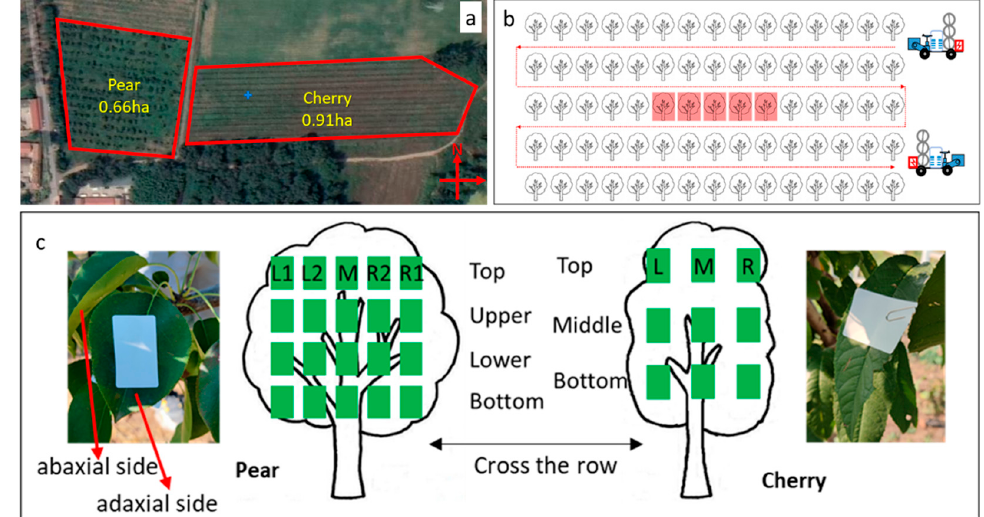
Figure 2. ( a ) Test fields for spray test ( b ) Layout of spray test: the red line showed the application route, trees with red background were sampled; ( c ) Sample site: green marks represented samples. The indicators L, M, R in the cherry canopy and the L1, L2, M, R2, R1 in the pear canopy represent the sample positions in per